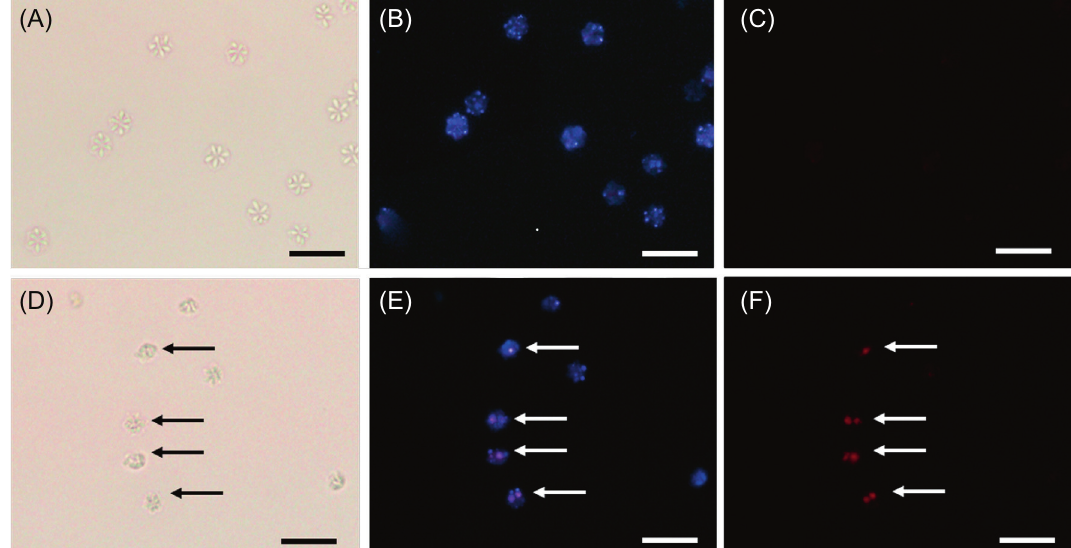
Figure 1. Kudoa septempunctata spores observed with normal light (A, D) and fluorescent light (B, C, E, F) and stained with Hoechst 33342 (blue fluorescence: B, E) and propidium iodide (red fluorescence: C, F). A–C, control (live spores, untreated); D–F, Ampros-treated spores. Arrows indicate dead spores. Scale, 20 l m.